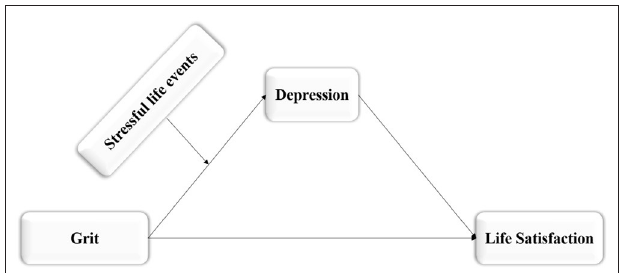
FIGURE 1 | The proposed moderated mediation